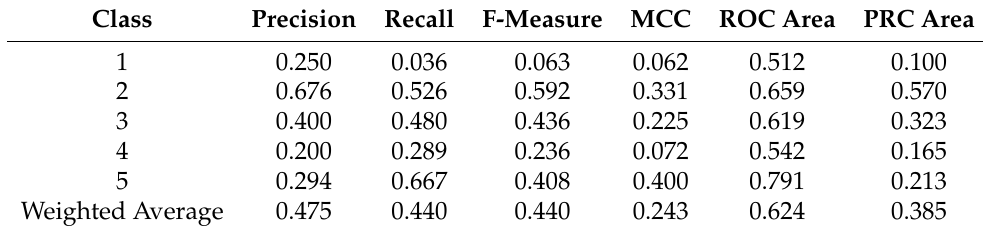
Table 12. CHIRP accuracy details.